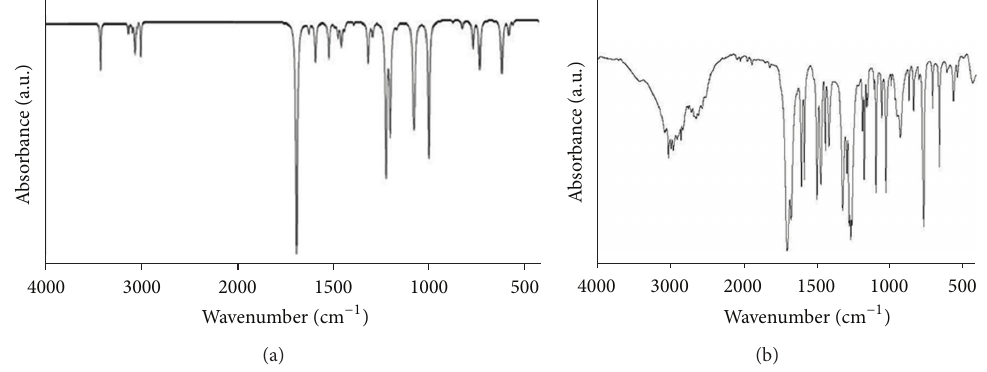
Figure 2: FTIR spectra of O-Anisic acid (a) observed and (b) calculated with B3LYP/6-31G ∗∗ .